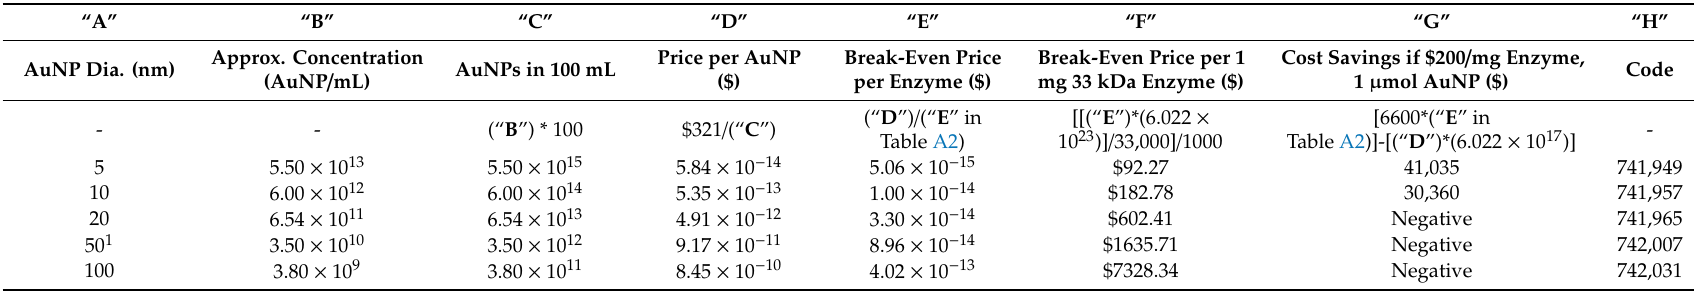
Table A3. Price comparison, using data from Sigma-Aldrich (St. Louis, MO, USA), accessed 22 November 2019, focusing on AuNP stabilized suspension in citrate bu ff er. All 100 mL samples were $321.